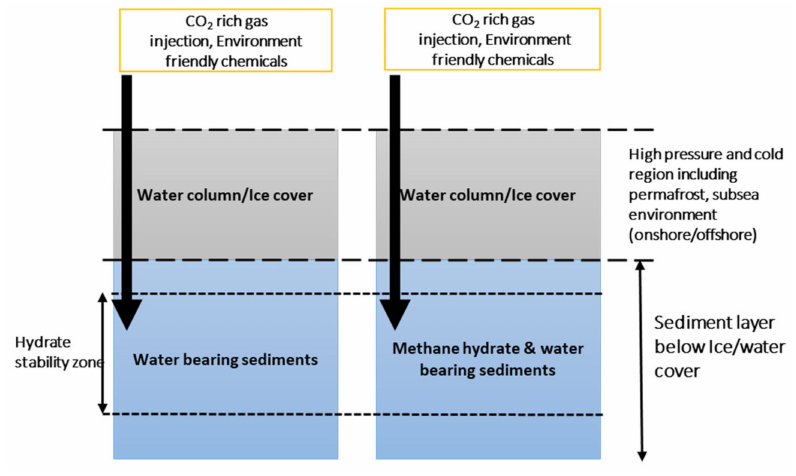
Figure 2. Potential geological locations for CO 2 capture and